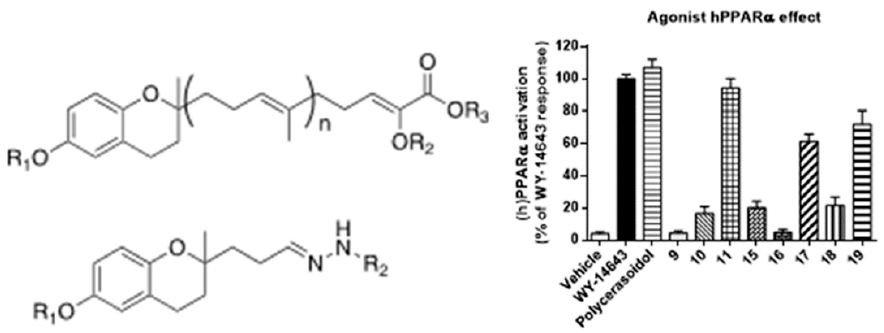
Figure 26. Left: General structure of prenylated benzopyrans. Right: PPAR α activity. This work was funded by grants PFIS (FI19/00153) to C.V.V and Miguel Servet pro- gramme (CPII20/00010) to N.C. from the Carlos III Health Institute (ISCIII) co-funded by the European Social Fund (ESF) “Investing in your future”, and by grants PI18/01450, PI21/02045, AICO/2021/081 and APOTIP/2020/011 from the GVA, ISCIII and co-funded by European Regional Development Fund